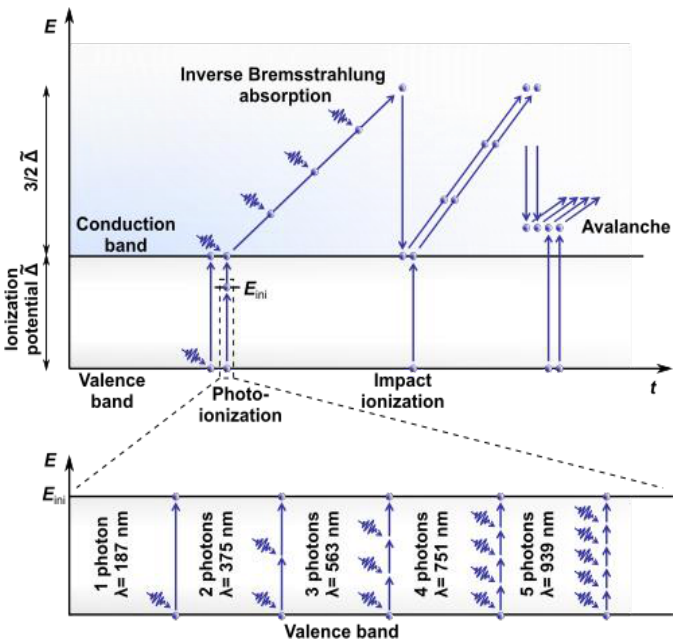
Figure 1. Ionization scheme for laser energy deposition in water.